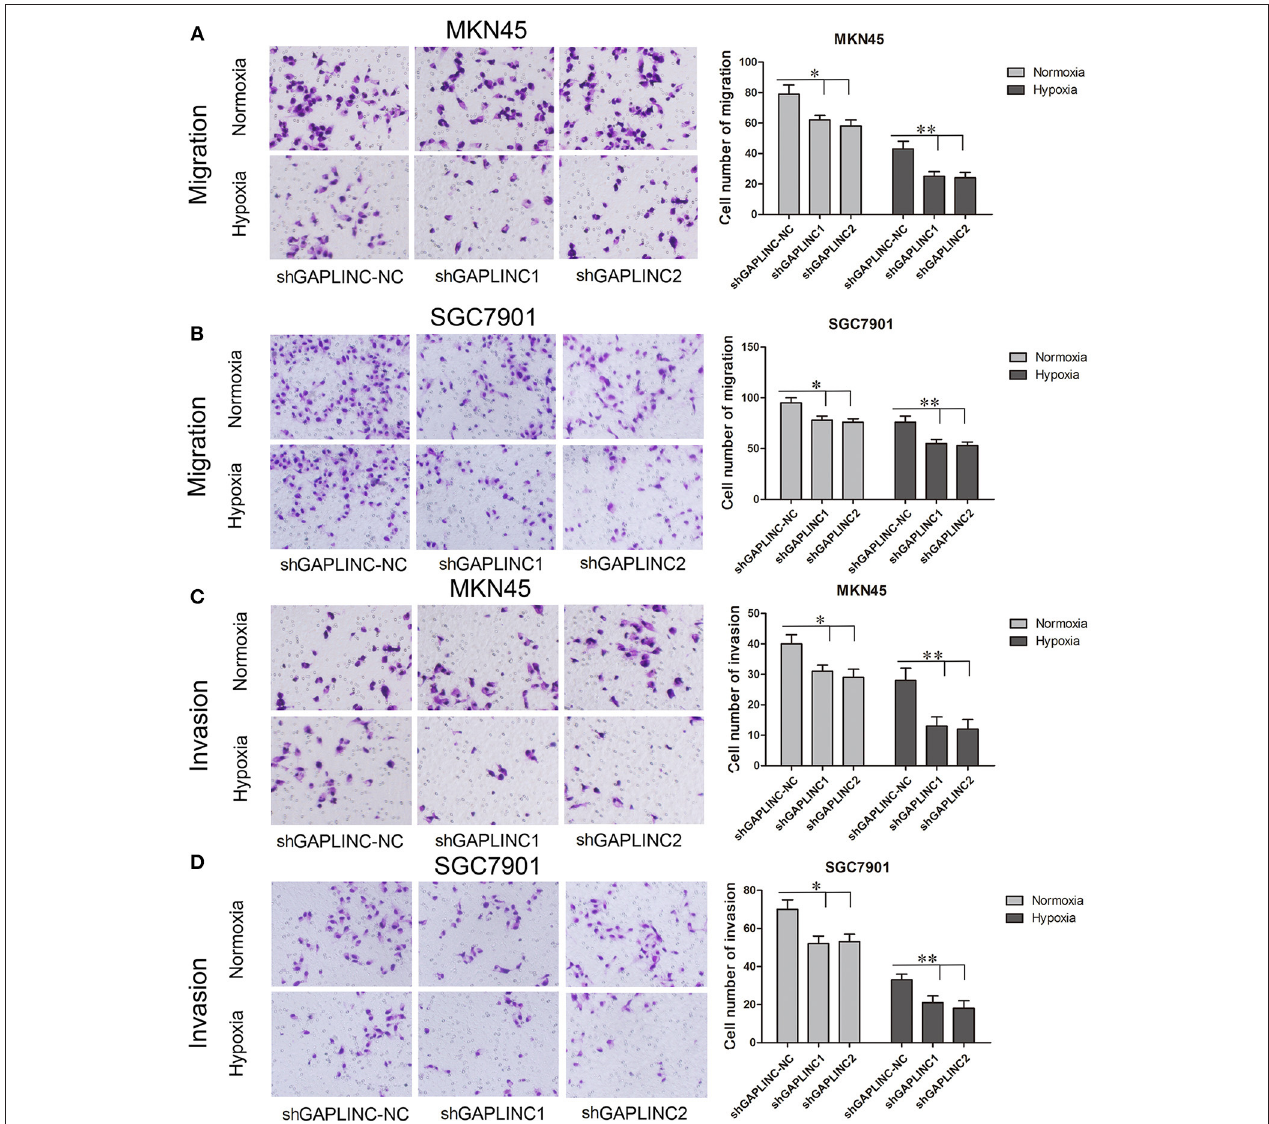
FIGURE 5 | GAPLINC promoted tumor cell migration and invasion abilities of MKN45 and SGC7901 cells especially under hypoxic conditions. Values represent the mean ± SD. (A,B) Cell migration abilities under nomoxia and hypoxia. (C,D) Cell invasion abilities under nomoxia and hypoxia (* P < 0.05, ** P < 0.05).